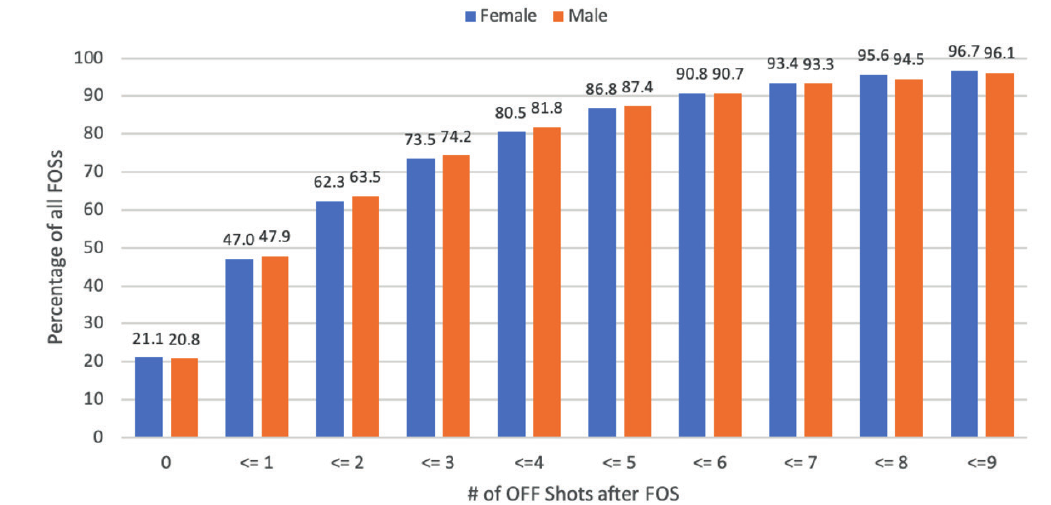
Figure 7. Distribution of the number of offensive shots after the